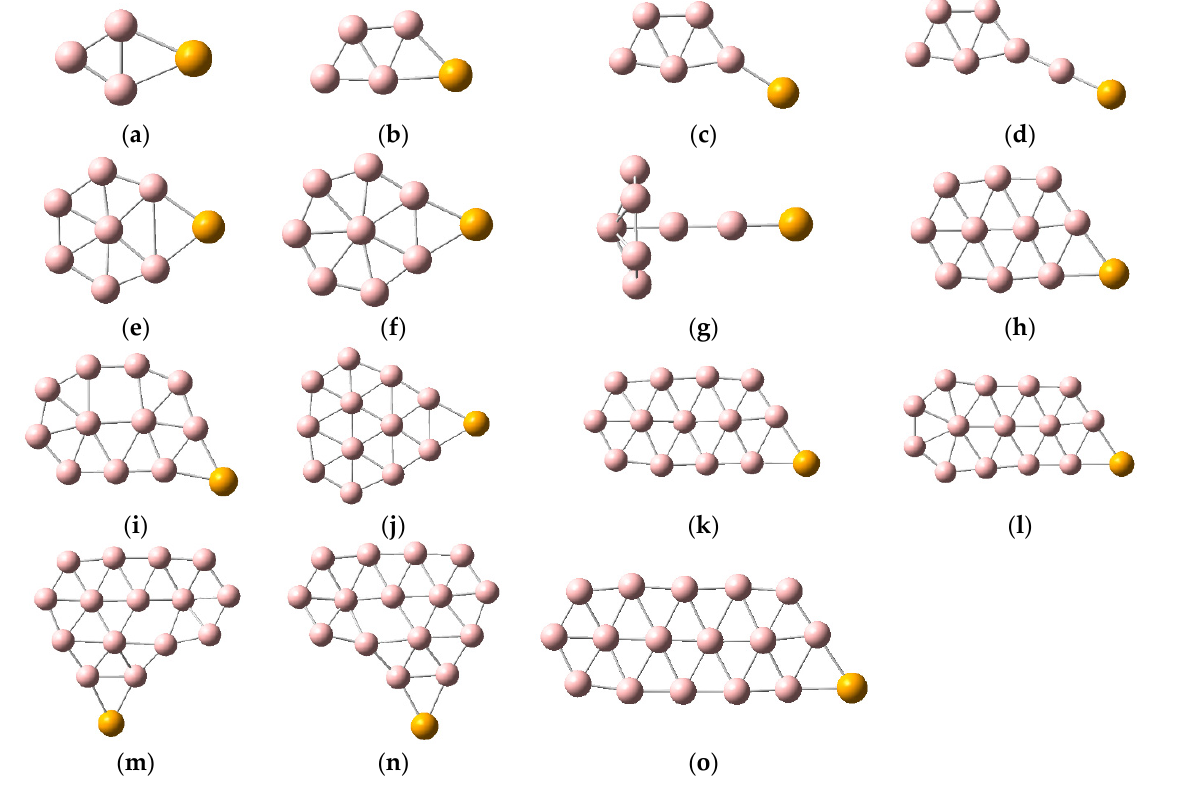
Figure 2. Structures of SeB n − . ( a ) SeB 3 − C 2V ; ( b ) SeB 4 − Cs; ( c ) SeB 5 − Cs; ( d ) SeB 6 − C 1 ; ( e ) SeB 7 − C 2V ; ( f ) SeB 8 − C 2V ; ( g ) SeB 9 − C 6V ; ( h ) SeB 10 − C 1 ; ( i ) SeB 11 − Cs; ( j ) SeB 12 − C 2V ; ( k ) SeB 13 − C 1 ; ( l ) SeB 14 − Cs; ( m ) SeB 15 − I C 1 ; ( n ) SeB 15 − II C 1 ; ( o ) SeB 16 − C 1 .